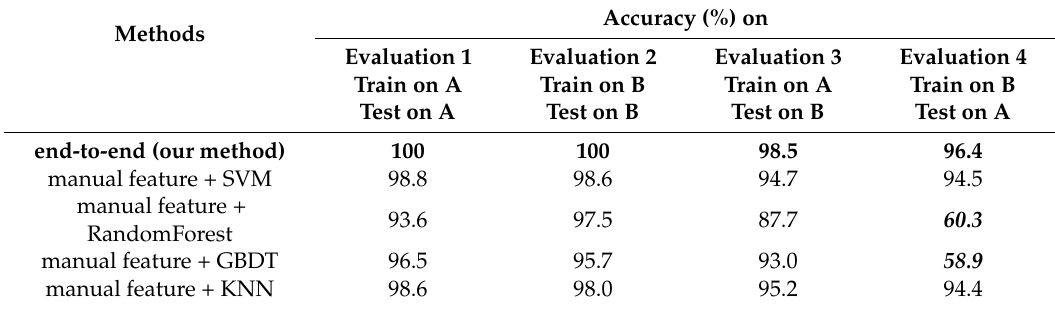
Table 3. The prediction accuracy on dataset A (without load) and dataset B (with load).